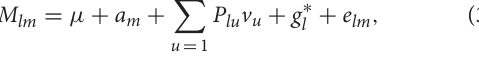
Frontiers in Plant Science |